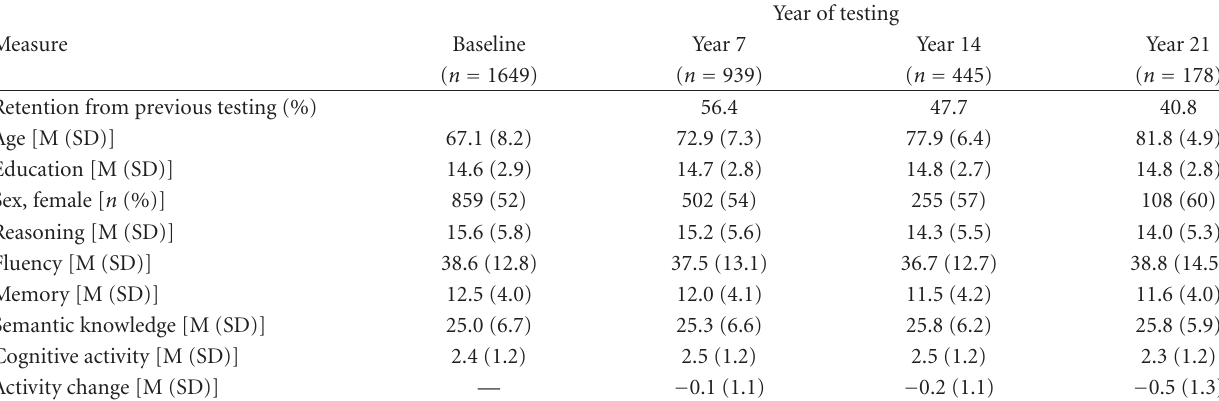
Table 3: SLS participant